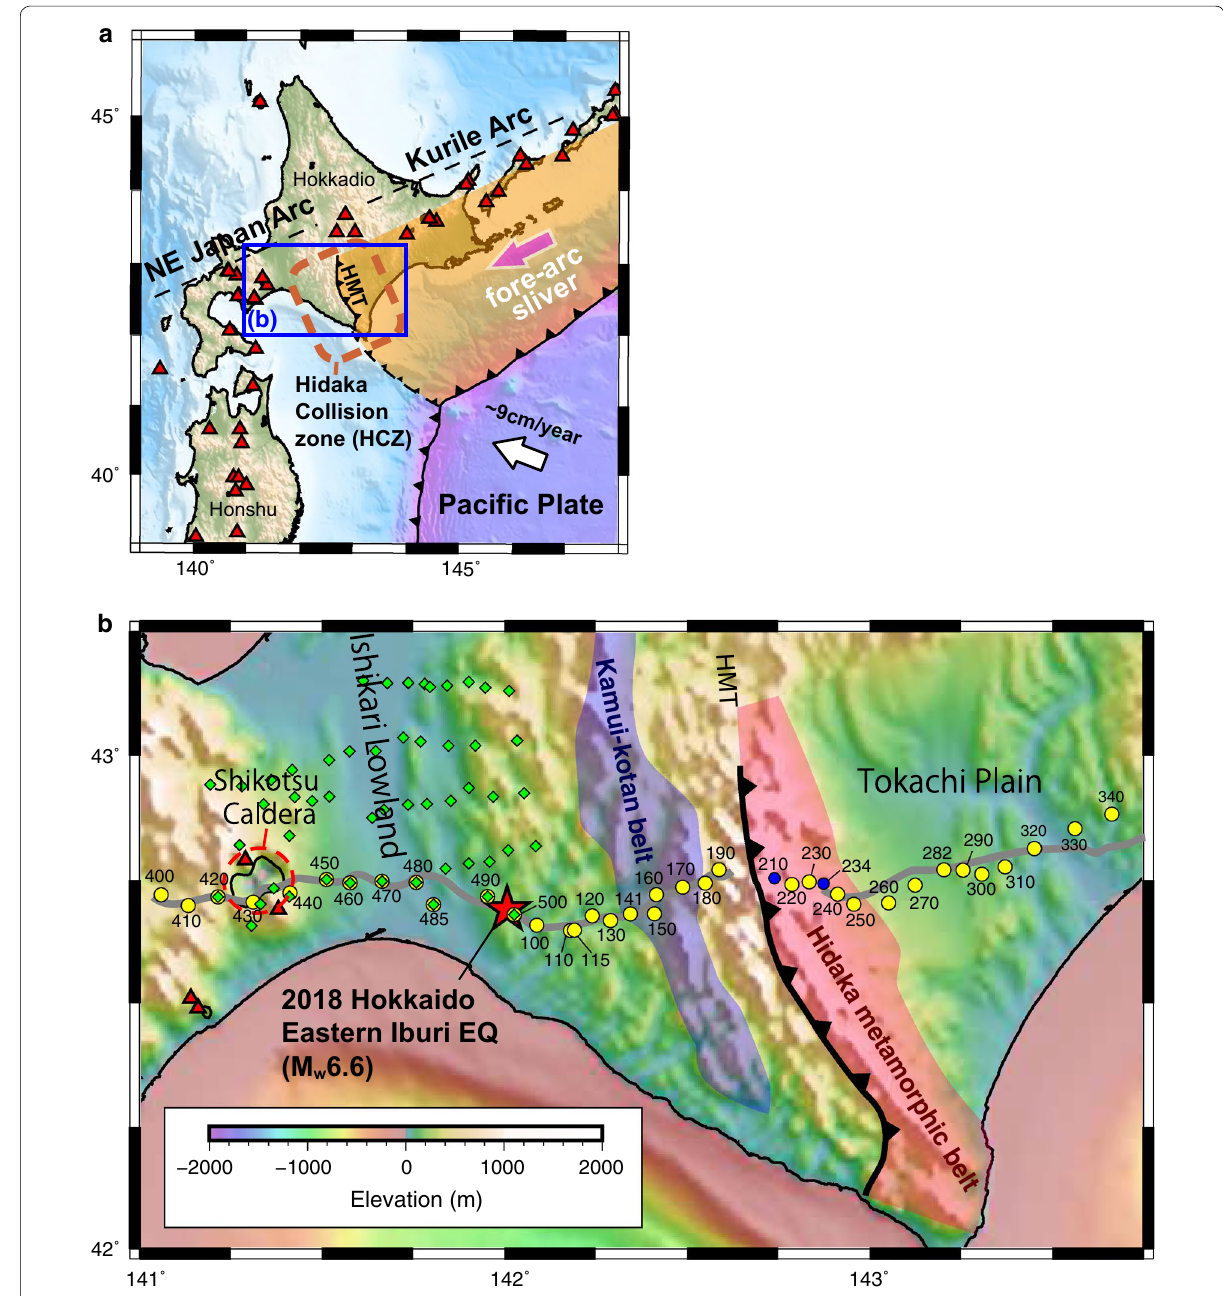
Fig. 1 Maps showing locations of the study area and MT stations. a Tectonic setting of the Hokkaido region showing the study area. Red triangles denote active volcanoes. b Map of the study area showing simplified local geology and the locations of MT stations. Yellow and blue circles denote MT stations used in 2000–2001 and 2005, respectively. Green diamonds are MT stations used in resistivity modeling by Yamaya et al. (2017). Note that MT data from stations 420 and 450–500 were used in the 3-D inversions of both this study and that of Yamaya et al. (2017). The gray line marks the seismic refraction/wide-angle reflection profile of Iwasaki et al. (2004). The background elevation image was constructed from the ETOPO1 global relief model (Amante and Eakins